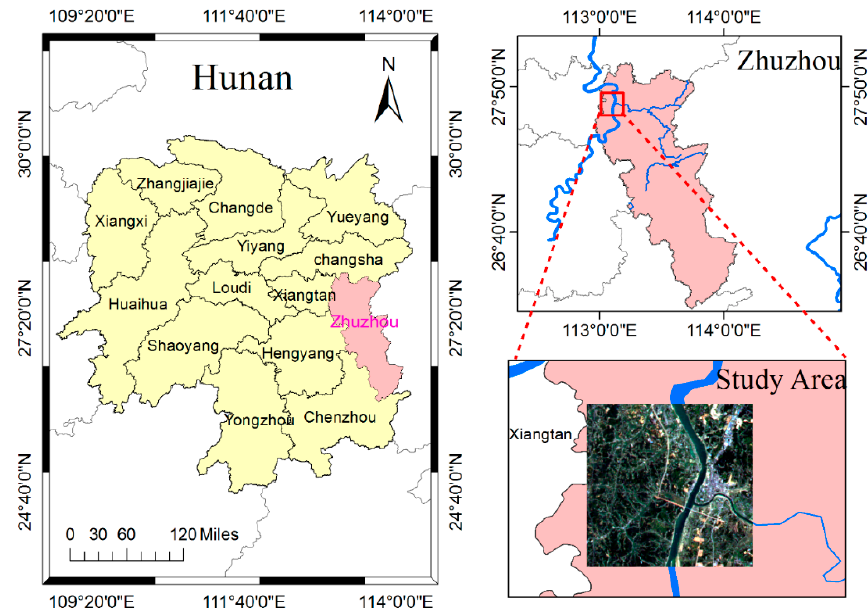
Figure 1. Location of study area.